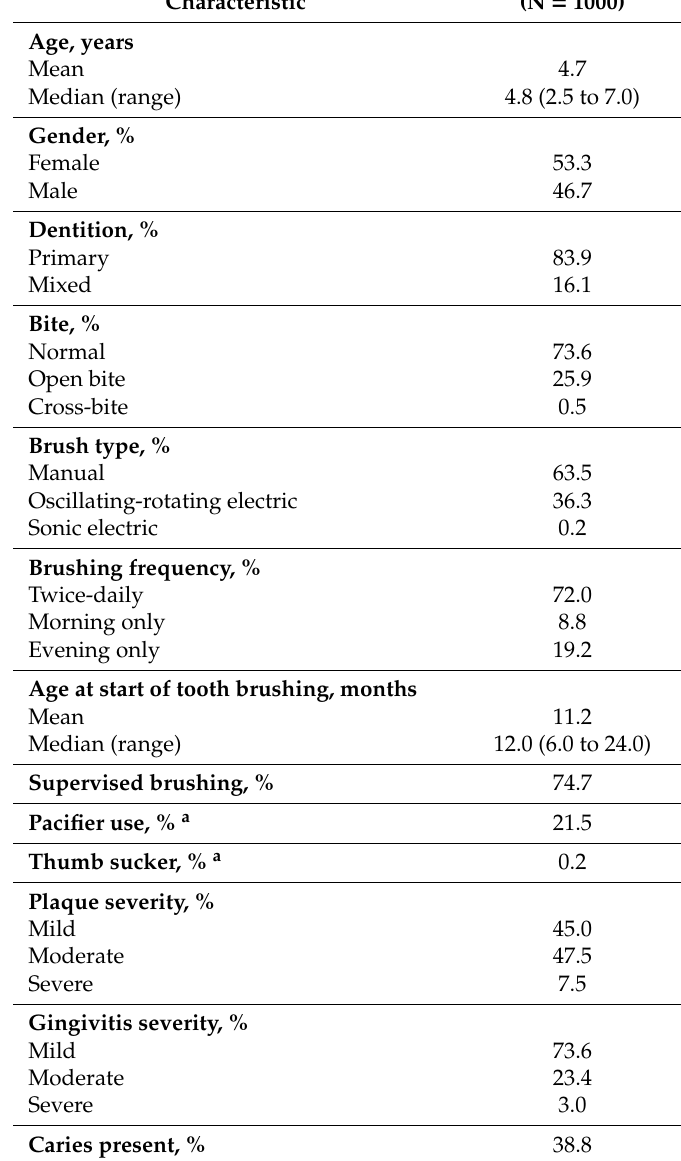
Table 1. Subject demographics and characteristics.